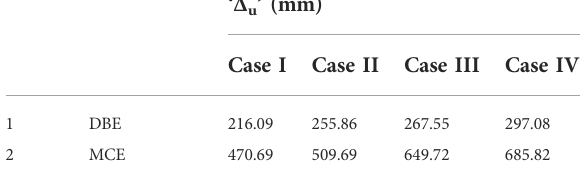
TABLE 6 Ductility demand for each building case.